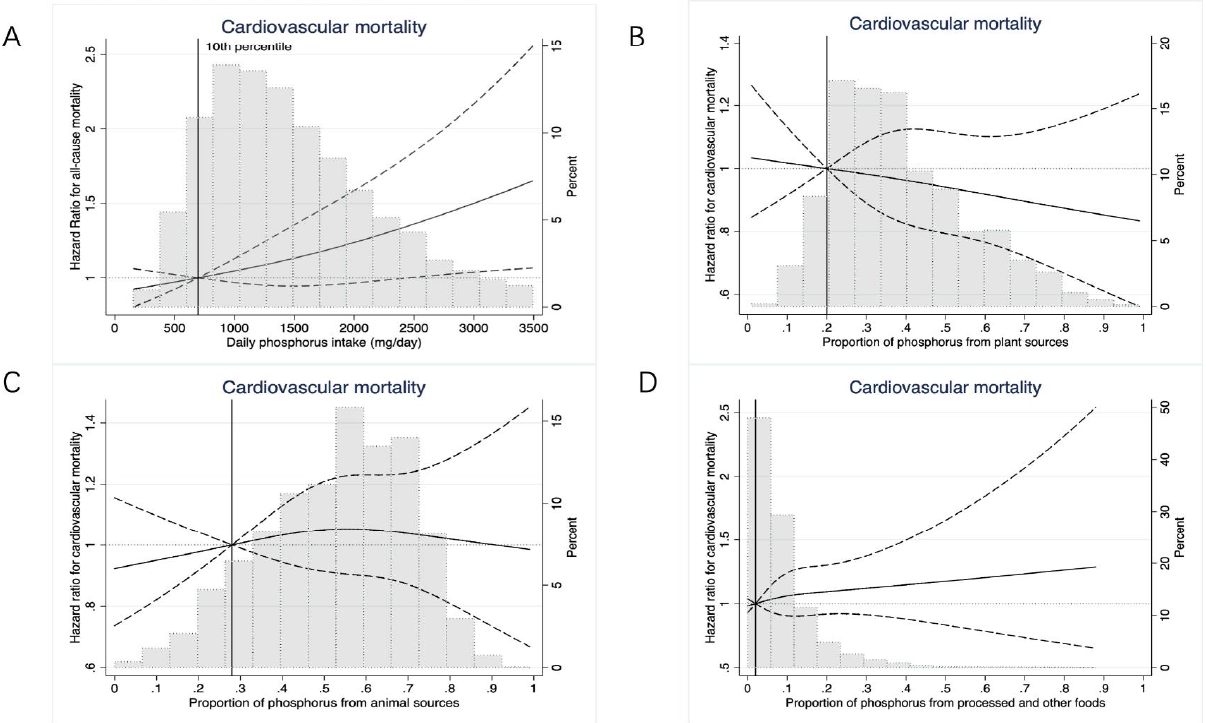
Figure 3. Adjusted restricted cubic splines of the association between daily phosphorus intake ( A ), proportion of phosphorus from plant ( B ), animal ( C ), other sources ( D ) and cardiovascular mortality. Restricted cubic spline models adjusted for age, sex, physical activity, smoking, body mass index, secondary education, history of cardiovascular disease, hypertension, diabe- tes, pulmonary disease, cancer, serum haemoglobin, serum albumin, serum calcium, statins, phosphate-binders (any or none), vascular access type (fistula versus graft/cathe- ter), dialysis vintage, Kt/V, total energy intake per day, potassium intake gram per day, Mediterranean diet score and alcohol consumption, and antihypertensive drugs (we in- cluded the total daily phosphorus intake as the covariate when investigating the associa- tion between the proportion of phosphorus from specific sources and mortality).